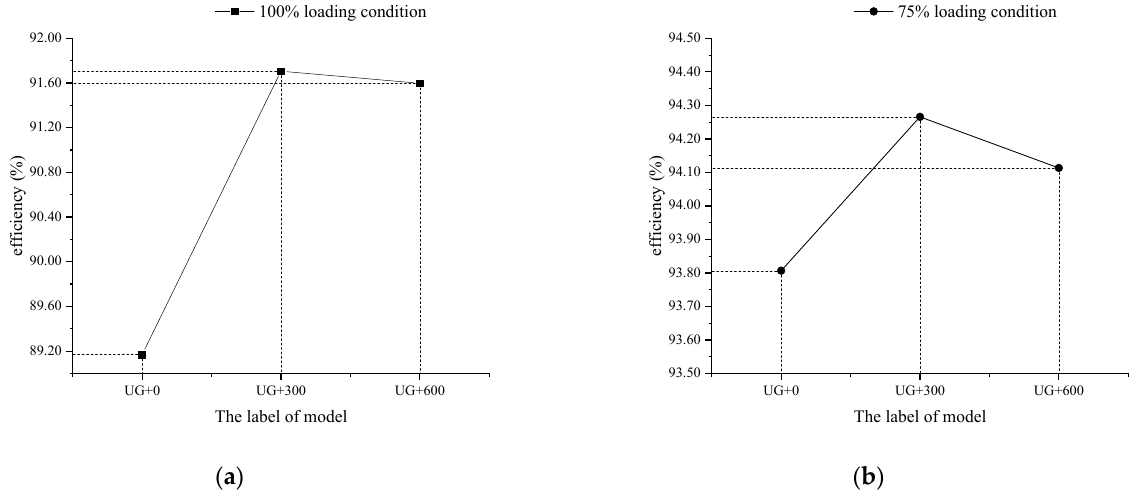
Figure 4. Comparison of efficiency. ( a ) 100% loading condition. ( b ) 75% loading condition.